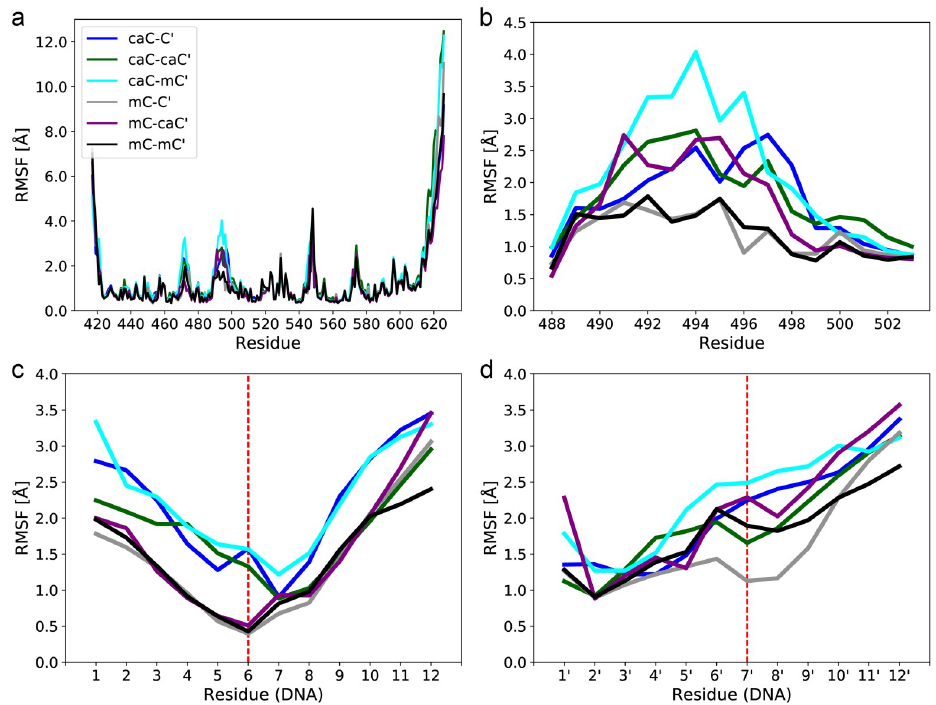
Fig 6. Root Mean Square Fluctuation (RMSF) of protein and DNA regions in molecular dynamics trajectories of UHRF1-SRA. (a) Full protein. (b) NKR finger. (c) DNA strand containing the flipped xC base bound by the protein. (d) Distal DNA strand containing the modified xC’ base. Red dashed lines show the xC/xC’ modification sites.